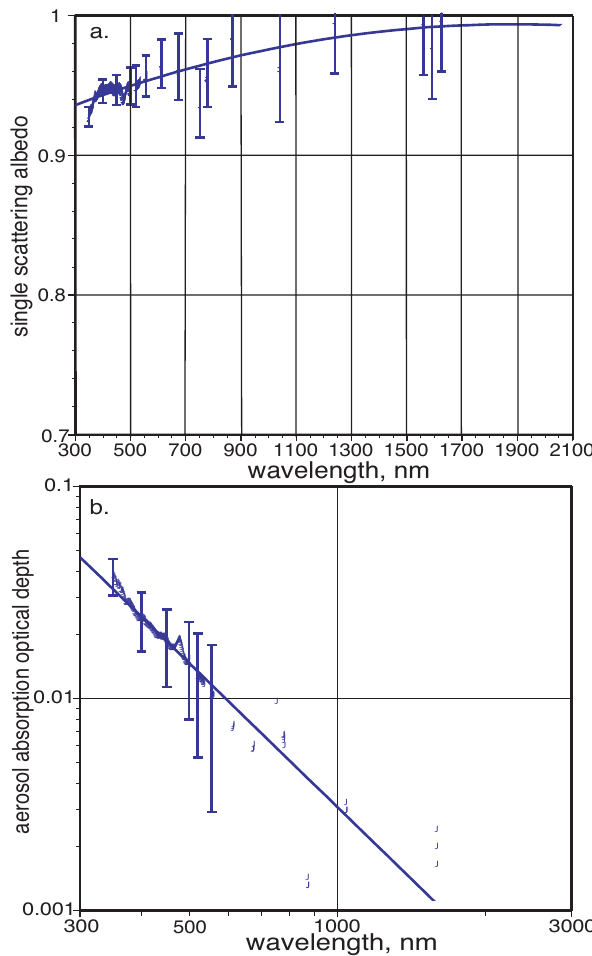
Fig. 4. a: Aerosol single scattering albedo and b: aerosol absorption optical depth for 10 March 2006. [note: for AAOD values below 0.01 the error bars are omitted]